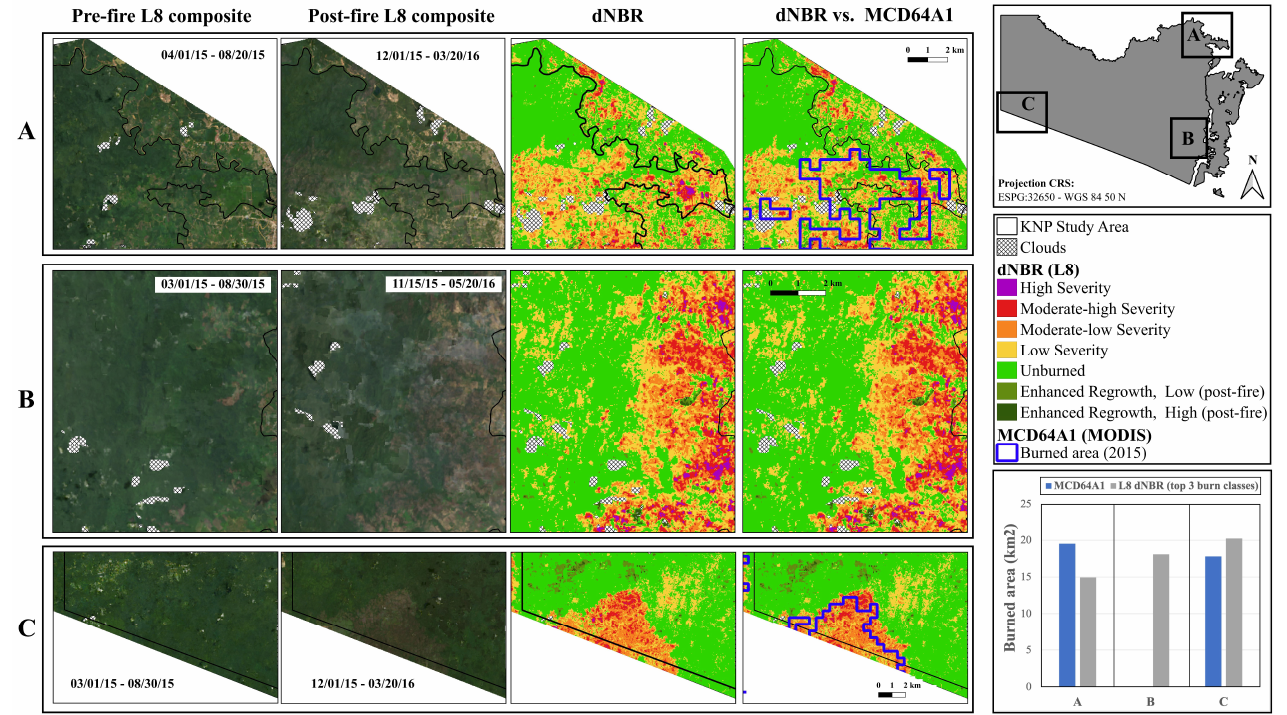
Figure 5. Validation of MCD64A1 burned area in 2015 over northwestern ( A ), southeastern ( B ), and southwestern ( C ) sample regions of Kutai National Park using differenced normalized burn ratio (dNBR) of pre- and post-fire Landsat 8 composite imagery. In the bottom right chart, the spatial extent of the MCD64A1-detected burned areas is compared against the top three classes of dNBR burn severity over each sample